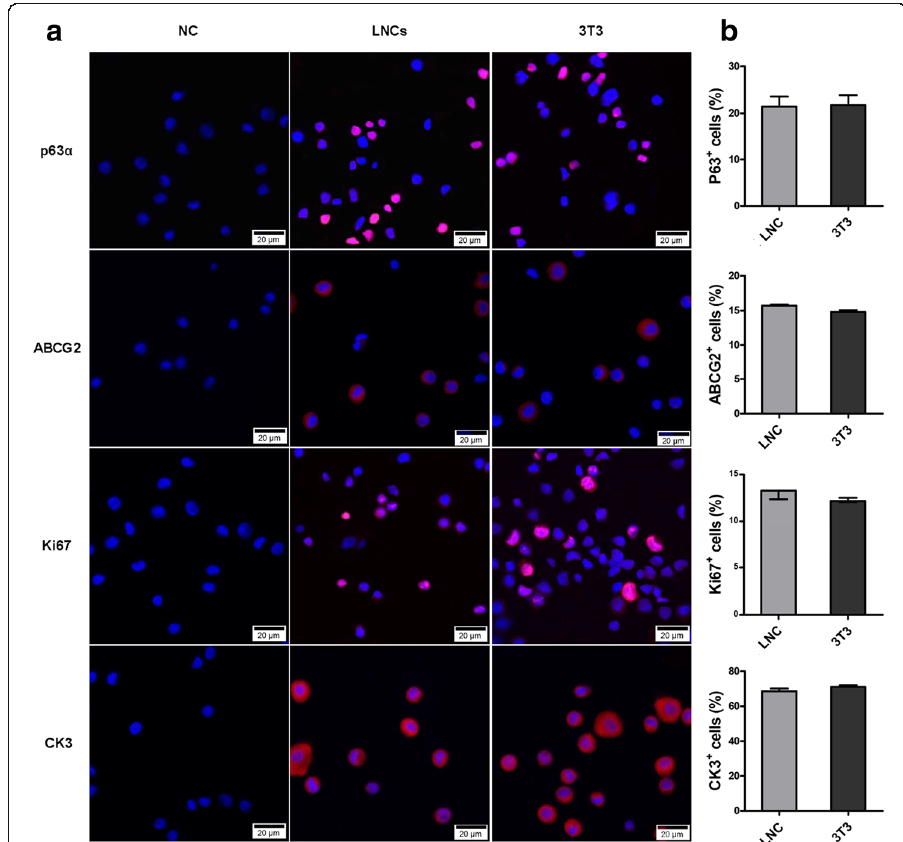
Fig. 3 Identification and quantification of cell markers of cultivated oral mucosal epithelial cells (COMECs) co-cultured with LNCs and 3T3 cells. a Representative images of p63 α , ABCG2, Ki67, and CK3 in different culture systems. b The percentages of positive cells in different groups were approximately the same ( p >0.05). The results were expressed as mean±standard deviation (p63 α , ABCG2, and CK3) or median with interquartile range (Ki67). NC: negative control, LNCs: limbal niche cells, ABCG2: ATP binding cassette subfamily G member 2, CK3: cytokeratin 3, scale bars: 20 μ m